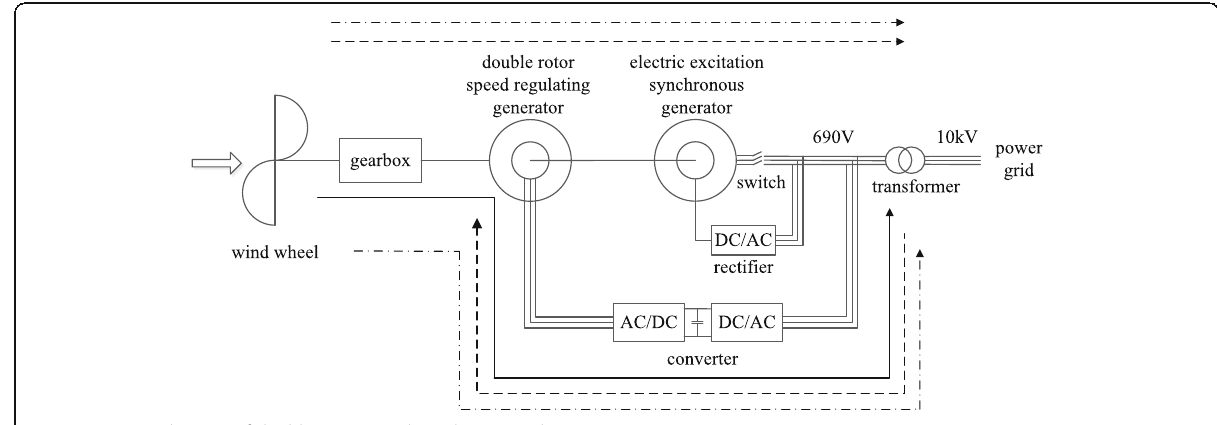
Fig. 3 Structure diagram of double rotor speed-regulating wind power generation